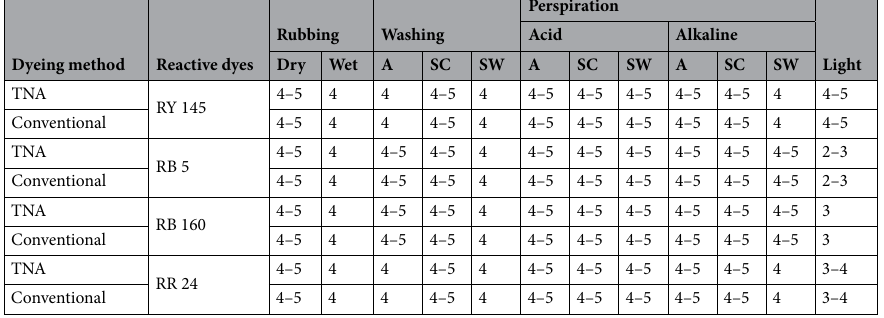
Table 5. The fastness properties of the dyed cotton fabrics (2% owf) using both conventional dyeing method (SS, 50 g/L, SC 20 g/L) and TNA method (SS/SC-free 50 g/L TNA). A color change, SC staining on cotton, SW staining on